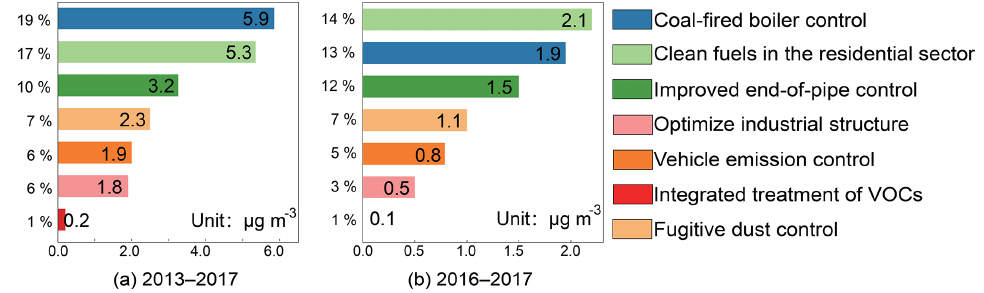
Figure 9. Contributions of the seven types of control policies to the PM 2 . 5 abatements in Beijing for the periods of 2013–2017 (a) and 2016–2017 (b) . The relative contribution rate of each policy to the total PM 2 . 5 abatements is presented on the Y axis. The number on each bar represents the normalized absolute PM 2 . 5 abatement by the relevant control policy.